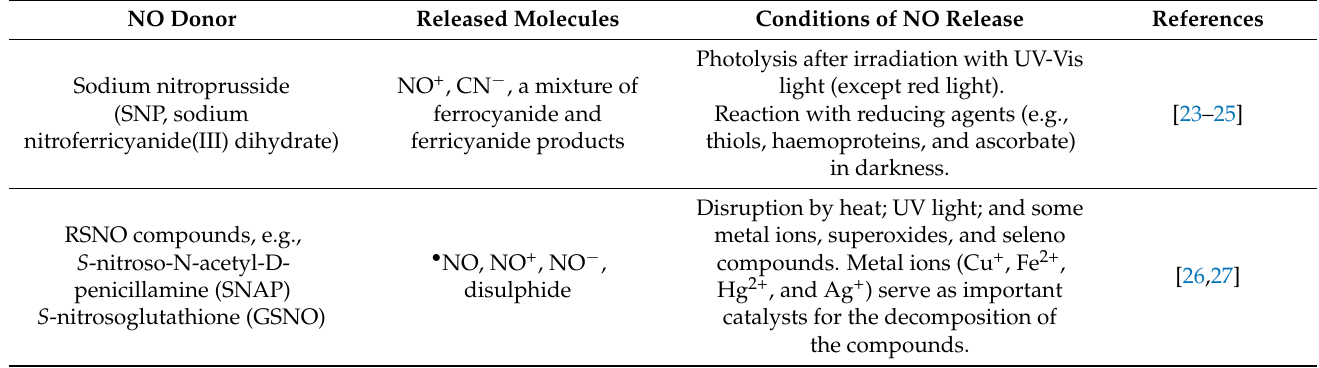
Table 1. The most commonly used NO